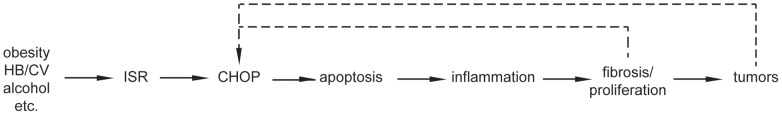
Model for the role of CHOP in HCC.The simplest interpretation of the data presented is a linear pathway whereby CHOP promotes apoptosis, which in turn activates inflammatory signaling, leading to fibrosis, compensatory proliferation, and ultimately tumorigenesis. Fibrosis and cellular transformation might in turn exacerbate cellular stress and CHOP expression, amplifying the tumor-promoting function of CHOP.